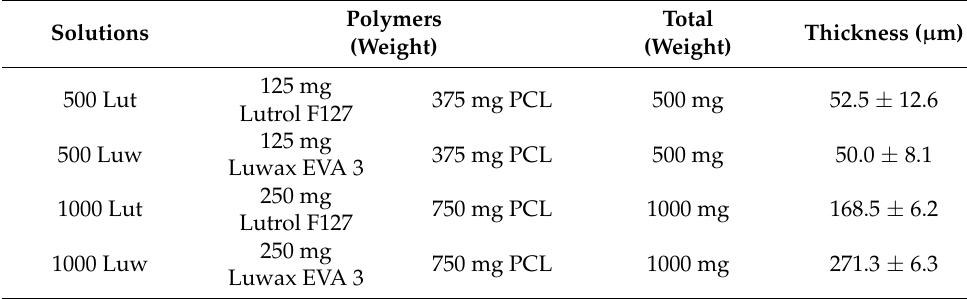
Table 5. Composition and thickness of coating films.